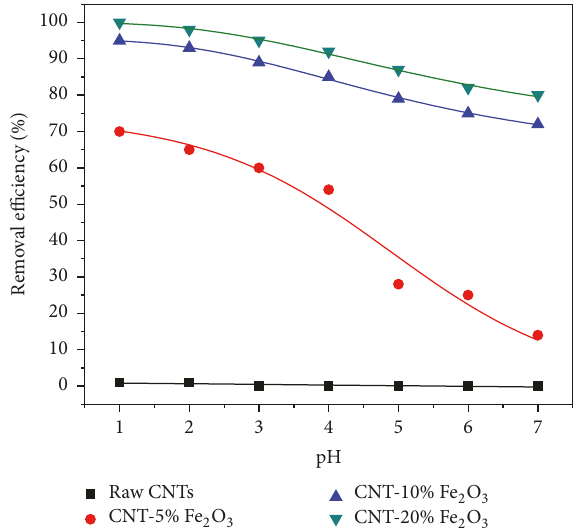
Figure 5: BET adsorption of N 2 at 77 K for raw CNTs and CNT-5% iron oxide, CNT-10% iron oxide, and CNT-20% iron oxide.